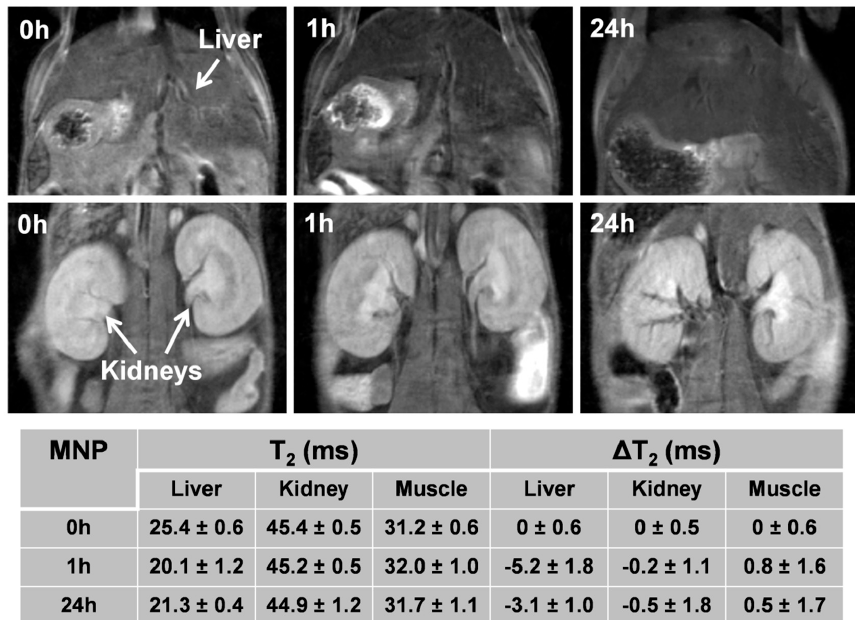
Figure 8. Representative T 2 -weighted MR images at di ff erent experimental times after the intravenous injection of PEGylated CF@MFNPs of liver (top) and kidneys (bottom). T 2 and ∆ T 2 values of liver, kidneys and muscle at di ff erent times after the intravenous injection of PEGylated CF@MF NPs. Values correspond to the mean ± standard deviation ( n =